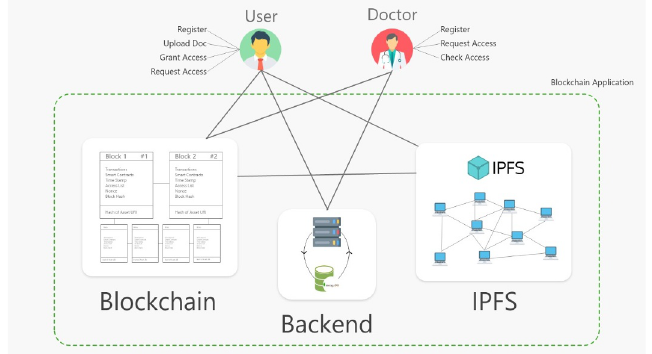
Figure 1. System